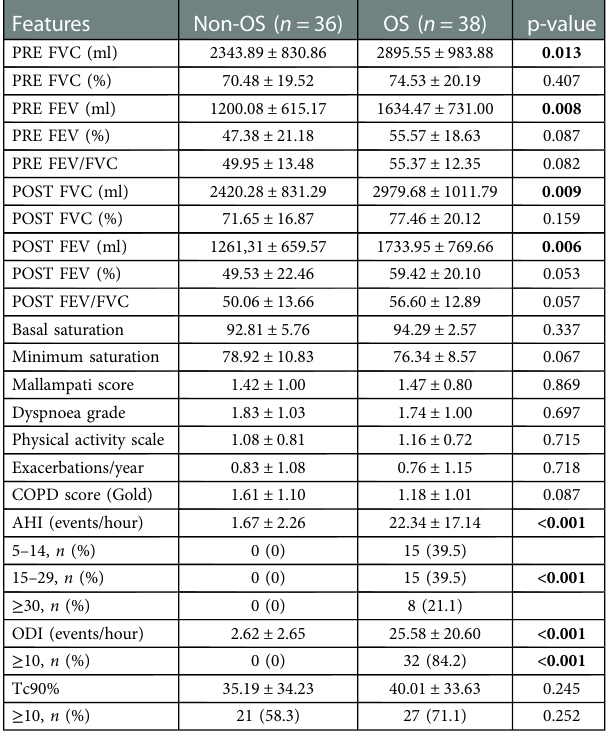
Table S3 . Multivariate logistic models were build with variables showing p -value <0.10 in univariate analysis, and revealed that only age [OR = 1.19 (95% CI: 1.07 – 1.32), p = 0.002], current smoking [OR = 10.50 (95% CI: 1.94 – 56.71), p = 0.006] and